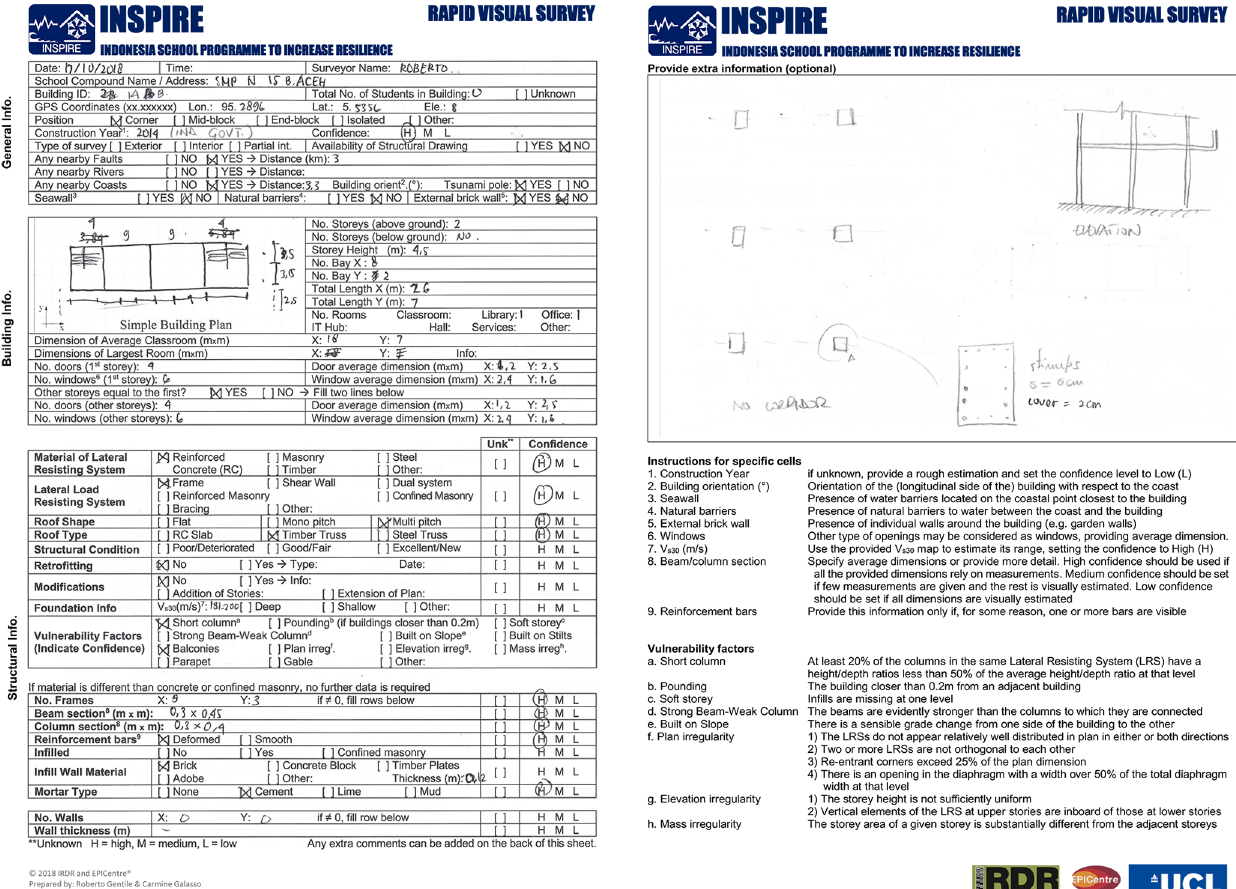
Figure 1. INSPIRE rapid-visual-survey form completed for a building with ID 14A (Sect.